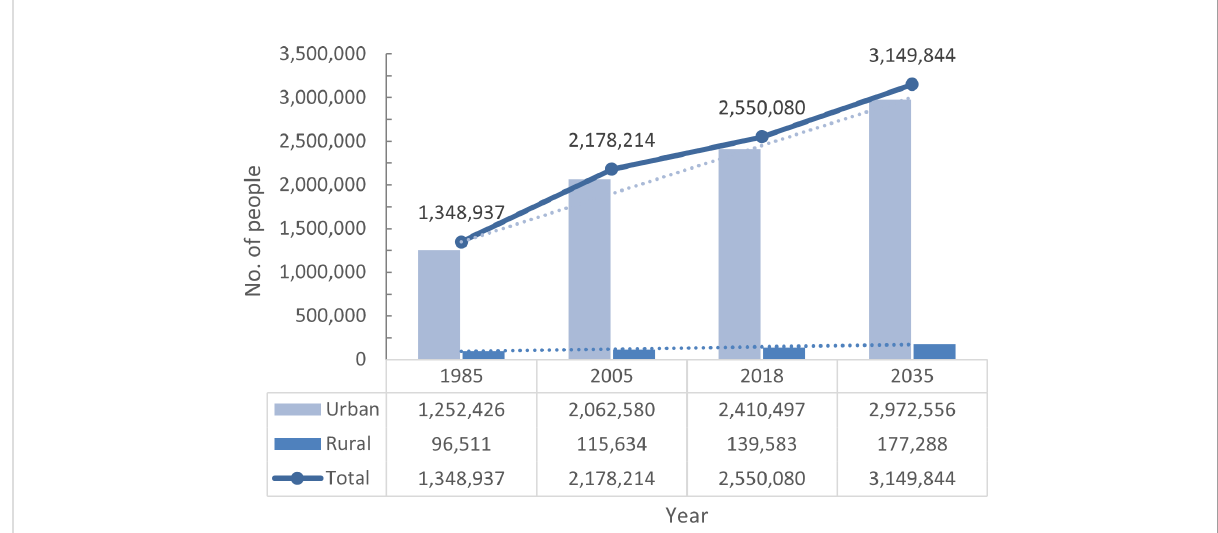
FIGURE 3 Population growth between 1985 and 2035. The 1985 and 2035 values are projected while the 2005 and 2018 values are from the corresponding census. Source: the authors with information from DANE